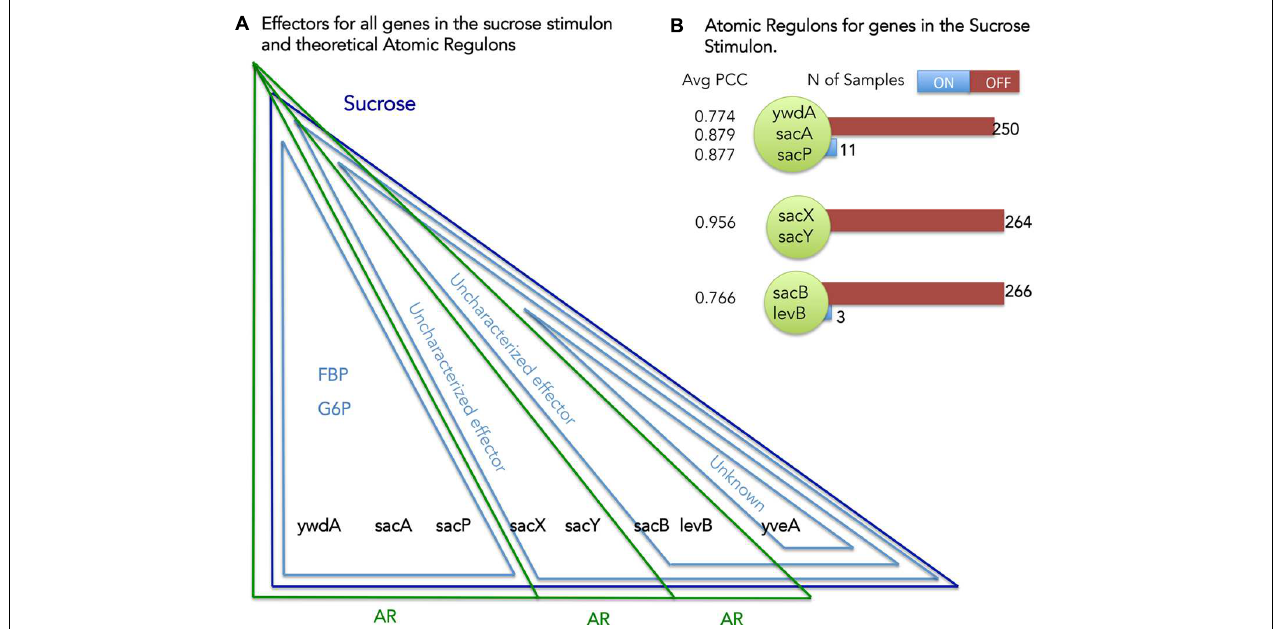
FIGURE 4 | Atomic Regulons (ARs) for the sucrose stimulon. (A) Effectors for all genes in the sucrose stimulon and theoretical ARs. Eight genes compose the sucrose stimulon (dark blue triangle). Fructose-biphospshate (FBP), Glucose-6-phosphate and uncharacterized effectors are also effectors (light blue triangles). The theoretical ARs are represented in green triangles. (B) ARs inferred for the sucrose stimulon. The ARs that were inferred are shown with the average Pearson correlation coefficient (PCC) and with a listing of the members of the AR. Number of samples ON and OFF for each AR is also shown.